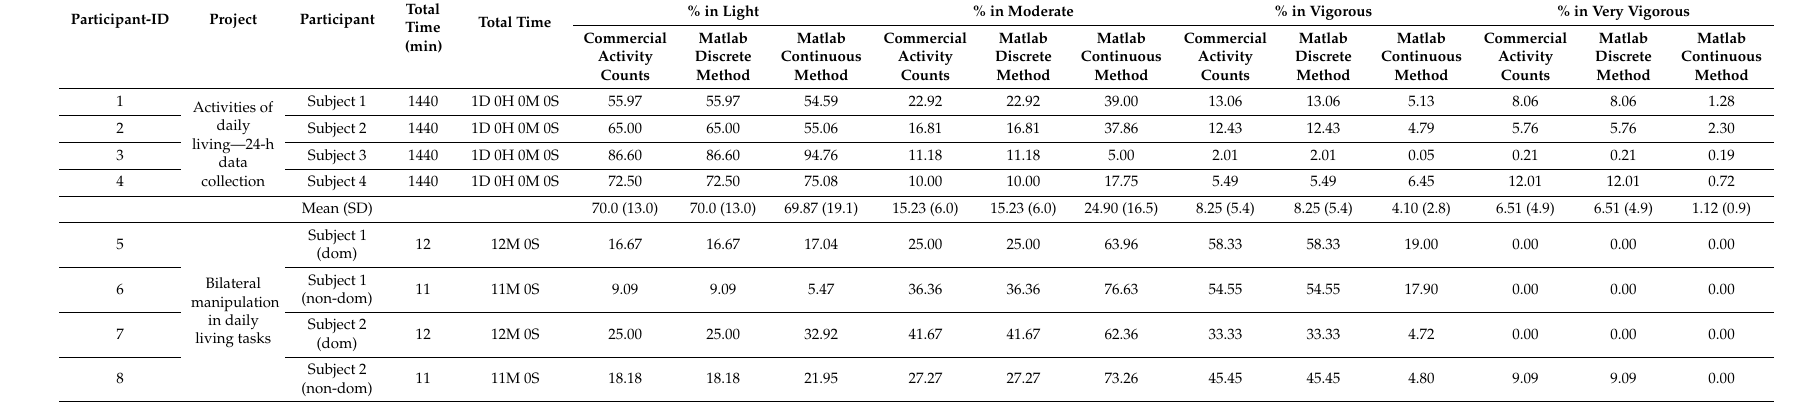
Table A3. Results of activity classification for the commercial activity count, the discrete and the continuous